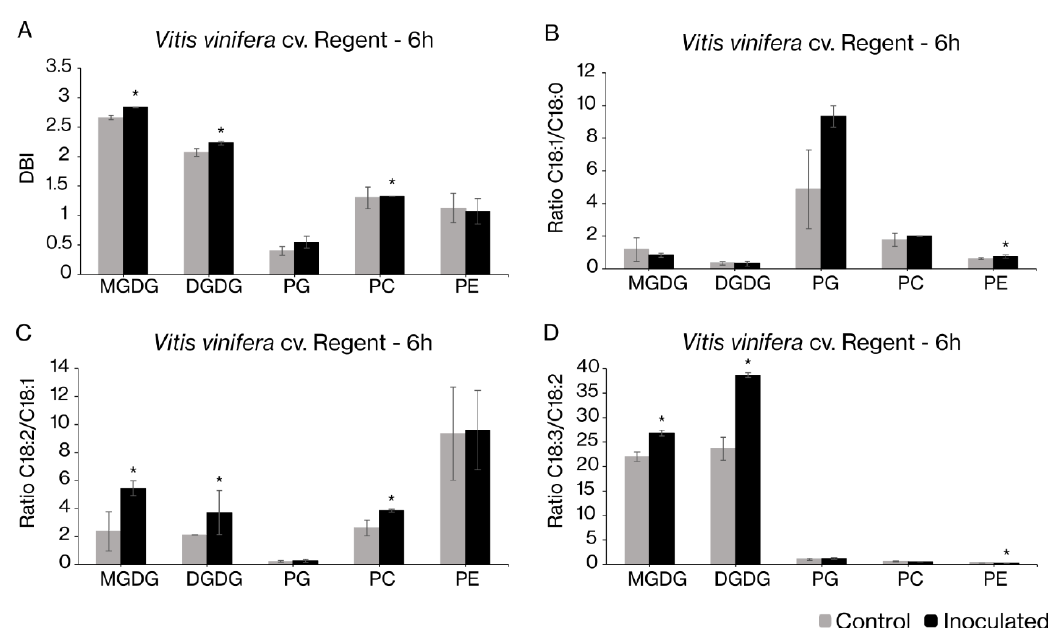
Figure 6. Fatty acid-related parameters of major leaf lipid classes of V. vinifera cv. Regent mock control and inoculated leaves with P. viticola at 6 h. ( A ) Double bound index (DBI); ( B ) Ratio between C18:1 and C18:0; ( C ) Ratio between C18:2 and C18:1; ( D ) Ratio between C18:3 and C18:2. Values correspond to average values ± standard error, n = 5; Asterisks indicate significant differences ( p < 0.05).